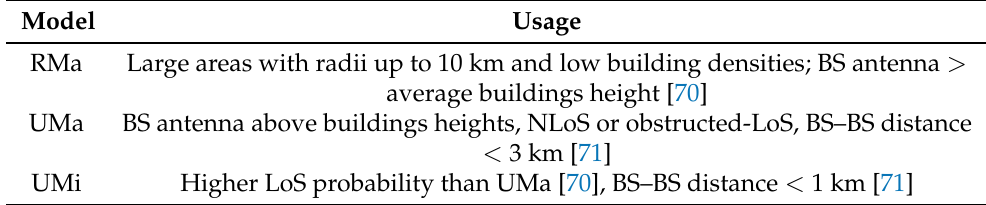
Table 3. UAV-to-ground models using